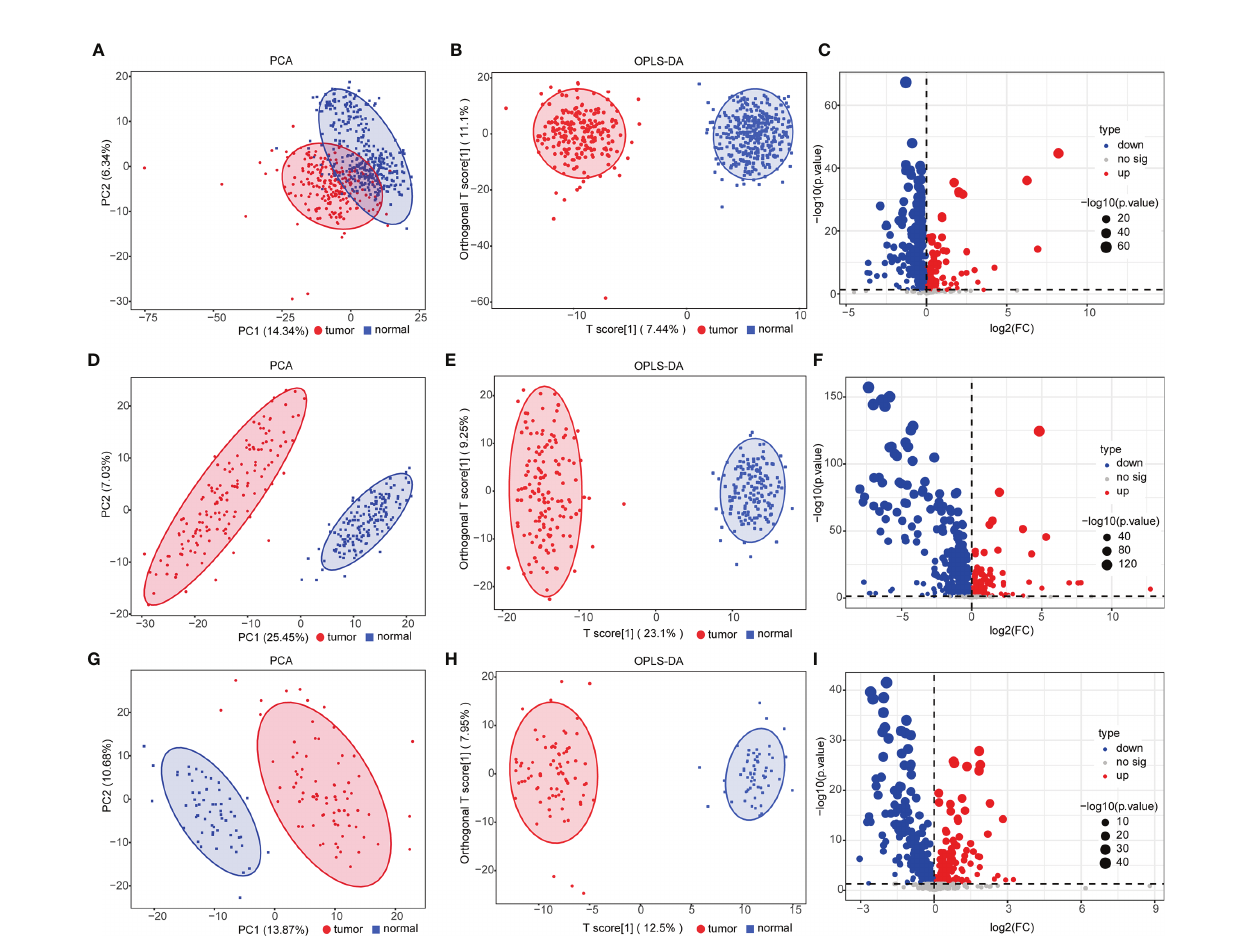
FIGURE 1 | Analysis of serum metabolomics of patients with esophageal squamous cell carcinoma (ESCC) and controls. (A, D, G) Principal component analysis (PCA) of metabolomic data from ESCC (red) and normal (blue) samples in the discovery group (A) and validation groups 1 (D) and 2 (G) . (B, E, H) Orthogonal partial least squares-discriminant analysis (OPLS-DA) score plot of all detected metabolites [ (B) discovery group, R2X = 0.295, R2Y = 0.949, Q2 = 0.918; (E) validation group 1, R2X = 0.323, R2Y = 0.976, Q2 = 0.973; (H) validation group 2, R2X = 0.279, R2Y = 0.968, Q2 = 0.942] in ESCC (red) and normal (blue) groups. (C, F, I) Volcano plot [ − log10( p -value) and log2(fold-change)] depicting upregulated (red) and downregulated (blue) metabolites in ESCC with p < 0.05 in the discovery group (C) and validation groups 1 (F) and 2 (I) . See also Tables S3 – S5